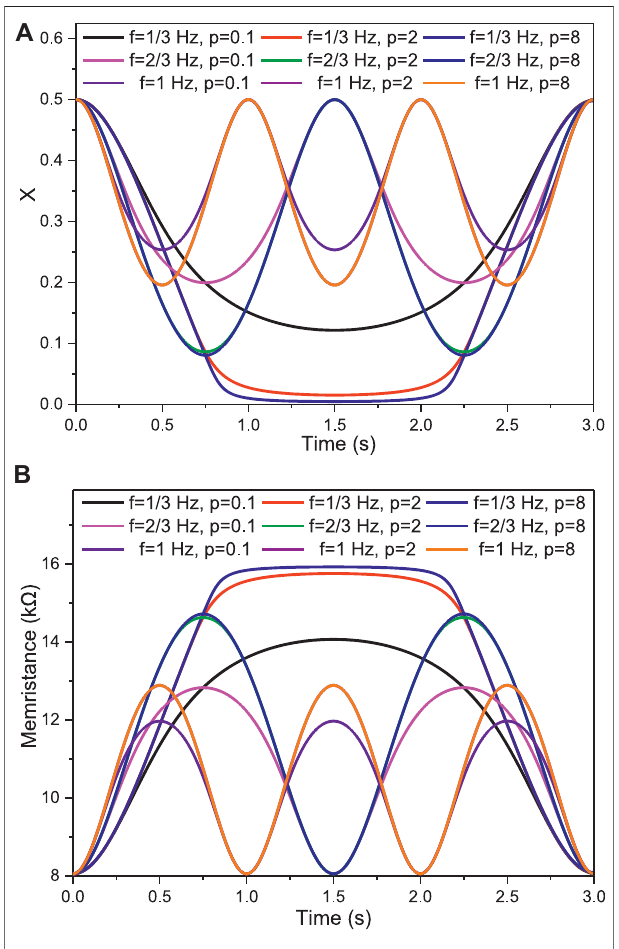
FIGURE 4 | In fl uence of the frequency variation of the biased voltage on the time-varying (A) state variable and (B) memristance.